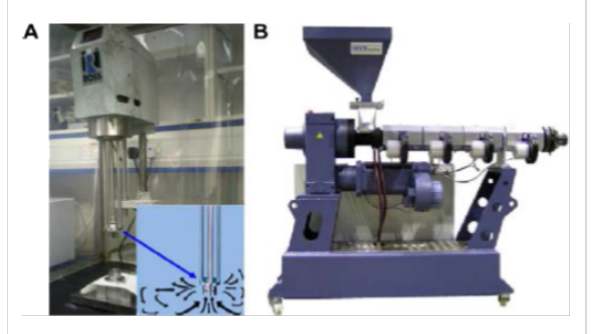
Figure 7: (A) Shear mixer, and (B) extruder. Reproduced with permis- sion from [40], copyright 2010 Elsevier.